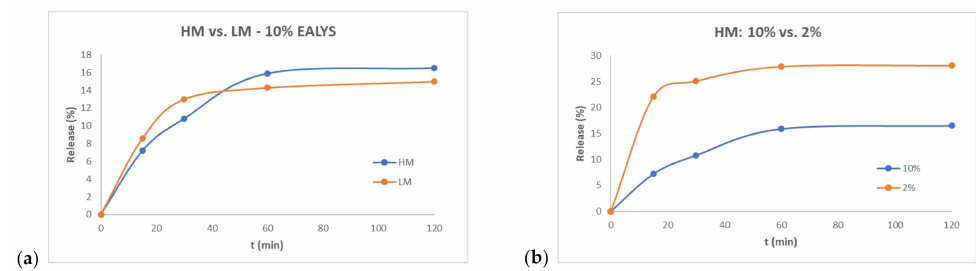
Figure 5. Release kinetics for the EA with lysine (EALYS)-loaded LM and HM pectin films in phosphate buffered saline (PBS) at pH 7.4 at 2 w / w %. ( a ): Release from LM + 10% EALYS vs. HM + 10% EALYS. ( b ): Release from HM + 10% EALYS vs. HM + 2% EALYS.